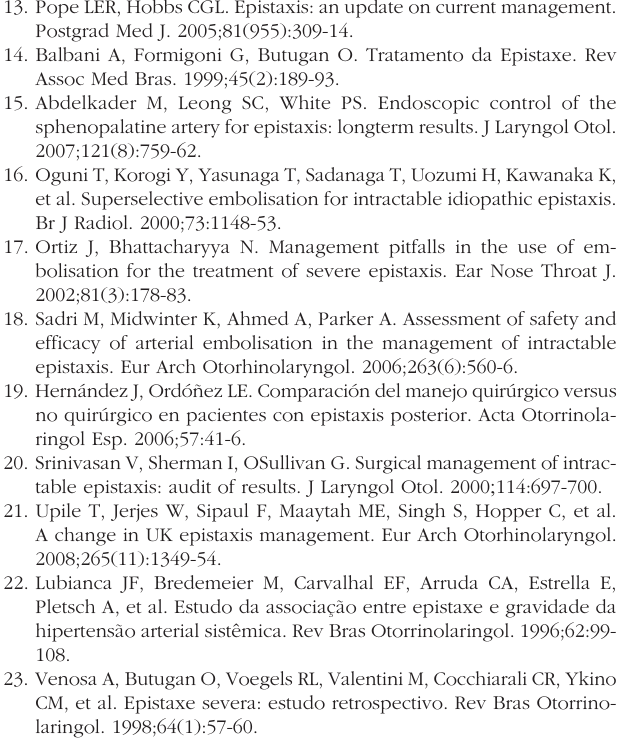
table epistaxis: audit of results. J Laryngol Otol. 2000 ; 114:697-700. 21. Upile T, Jerjes W, Sipaul F, Maaytah ME, Singh S, Hopper C, et